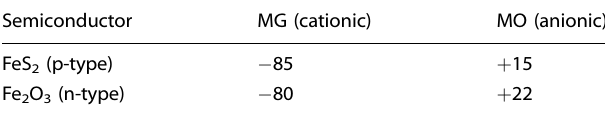
Reactor setup and photo-electrostatic dye degradation tests Degradation tests were conducted in a handmade, double-walled,